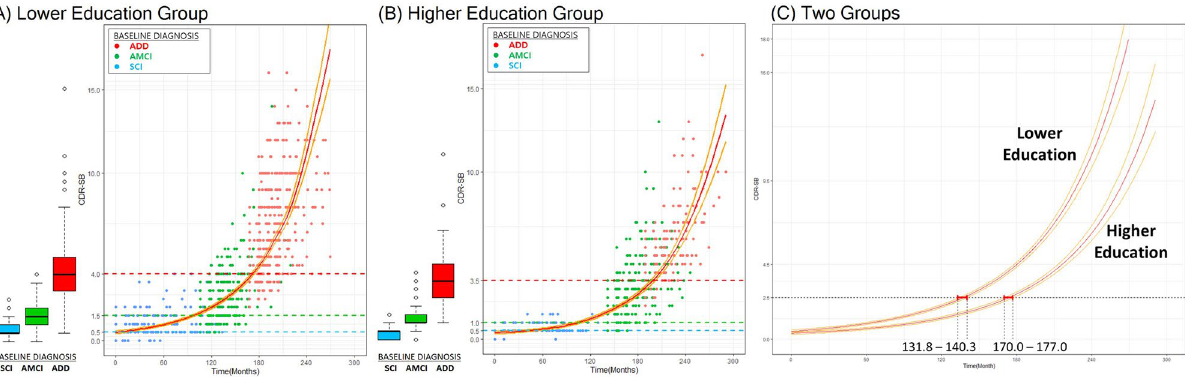
Figure 2. Disease progression model according to the level of education. Each dot indicates each follow-up CDR-SB value. The color of the dot is determined according to its baseline diagnosis cohort: SCI (blue), AMCI (green), and ADD (red). It takes less time to increase the CDR-SB value in the lower-education group in all sections. In the stages of SCI to AMCI, the CDR-SB value increases faster in the lower-education group. From the stage of AMCI to ADD, the CDR-SB value increases faster in the higher-education group. ( A ) Lower- education group. The estimated model in the lower-education group using CDR-SB. The predictive equation 2 is: In ( CDR SB + 0.5 ) = − 0.01585 + 0.005247 × time + 0.000021 × time × time . ( B ) Higher-education